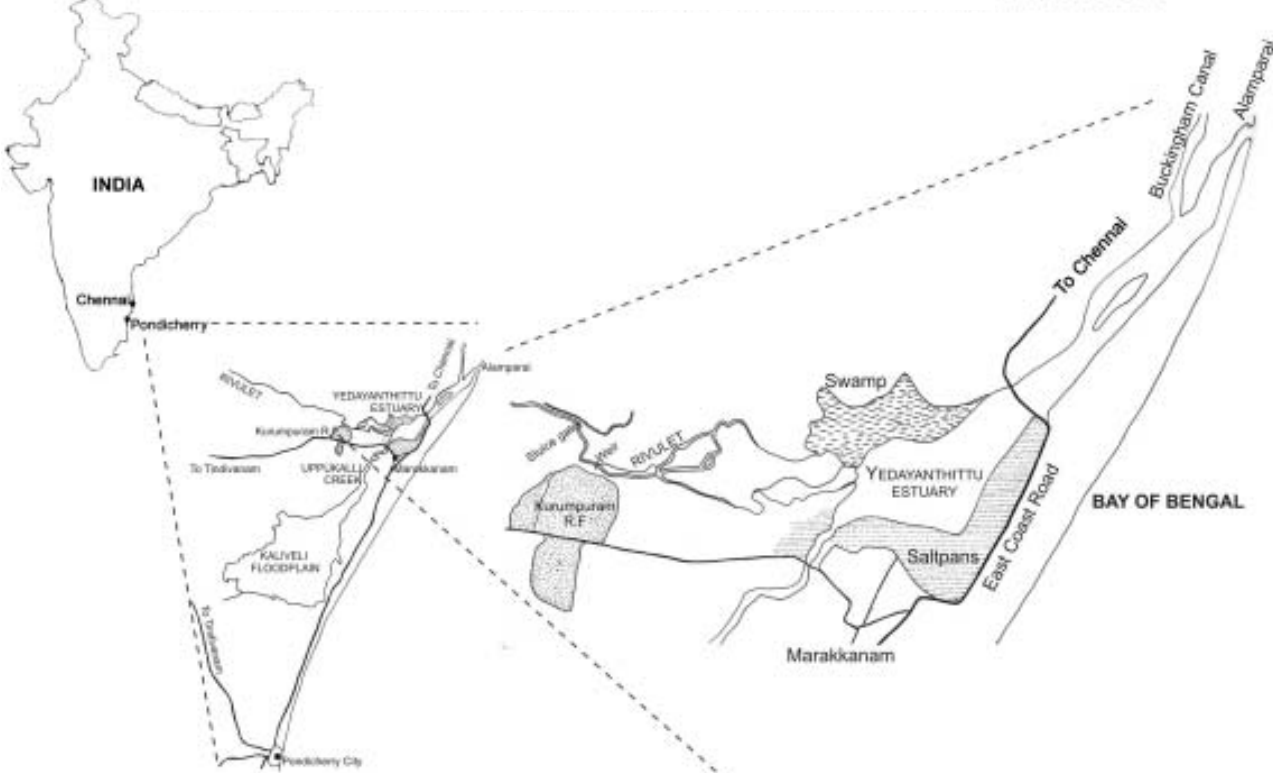
Figure 1. Areas of sampling - Yedayanthittu Estuary, Swamp and Rivulet north of Kurumpurum Reserve